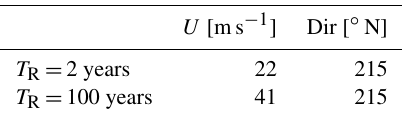
Figure 6. Wave field for the design wave condition H S = 6 . 85, T p = 11, Dir = 310 ◦ N. (a) Entire domain, (b) harbour entrance. The blue bullet is the extraction point location; its UTM coordinates are 371221 ◦ E, 4478470 ◦ N. Table 3. Wind conditions used as input to the MIKE21-SW wave generation model, Lamberti et al. (2015).